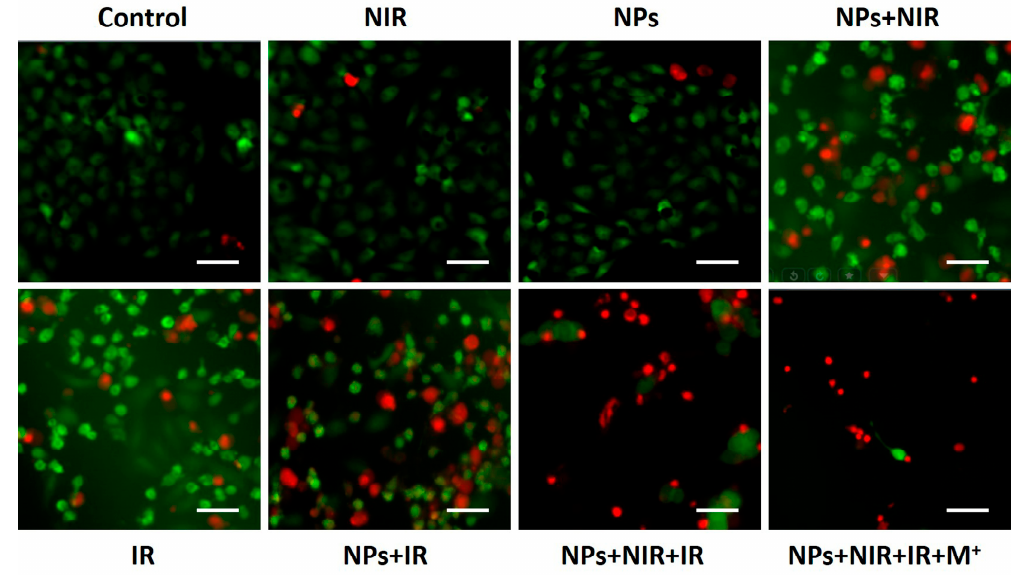
Figure 6. Live/Dead assay of HeLa cells after various treatment (scale bar: 50 mm).